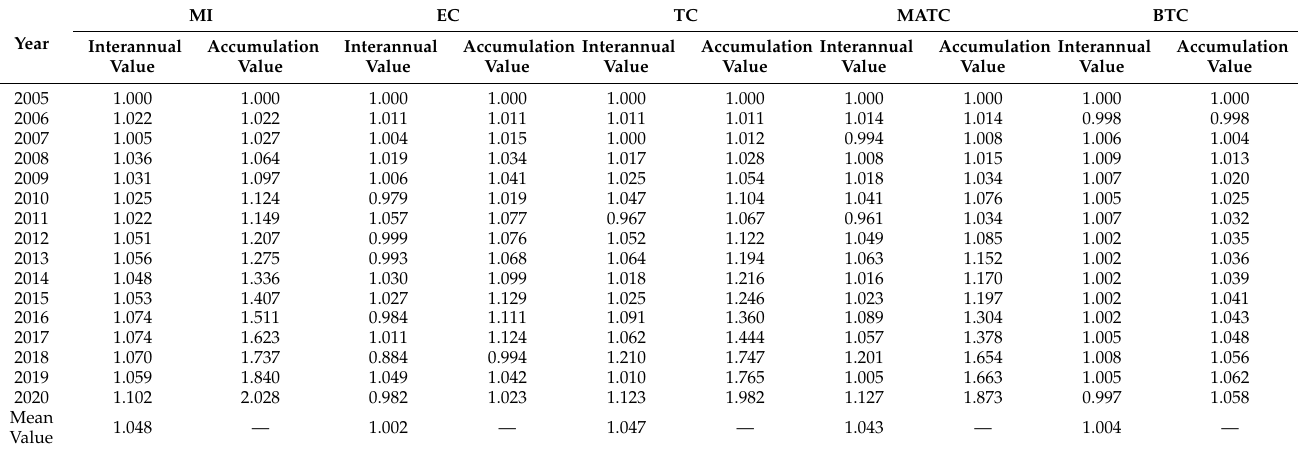
Table 2. The growth and causes of rural energy carbon emission efficiency in China from 2006 to